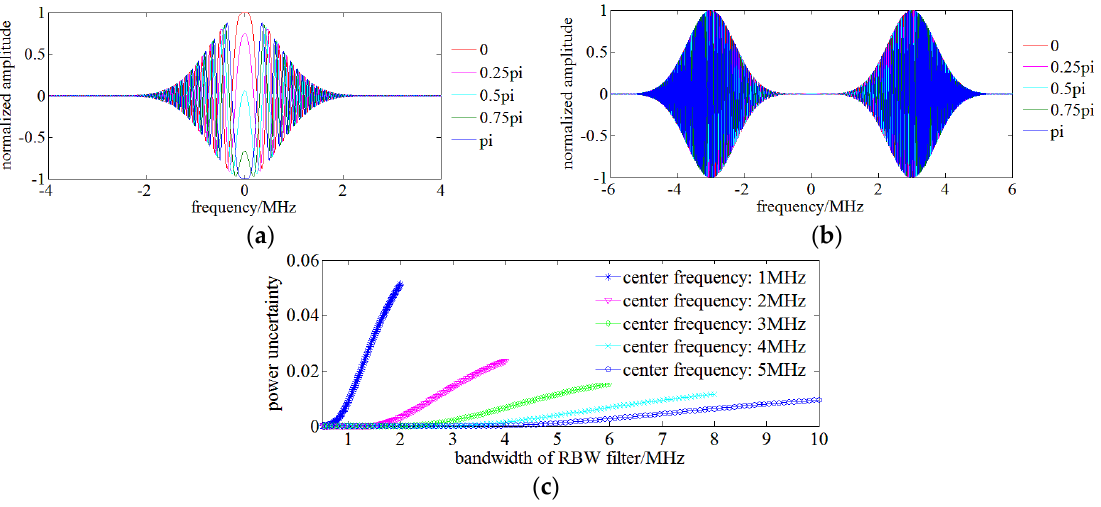
Figure 2. ( a ) Process of chirp signal with different initial phase using a low pass RBW filter; ( b ) Chirp signal process with different initial phases using a band pass RBW filter; ( c ) The relationship between power uncertainty and the parameters of the RBW filter.